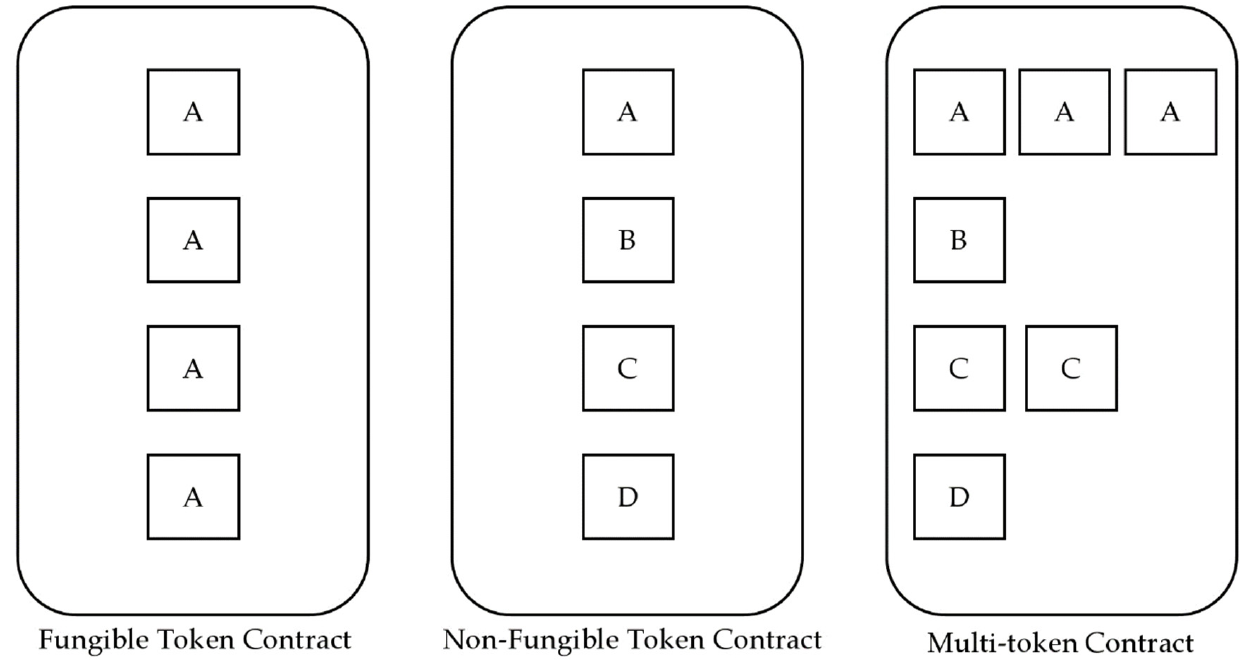
Figure 5. Characteristics of blockchain tokens by standard.